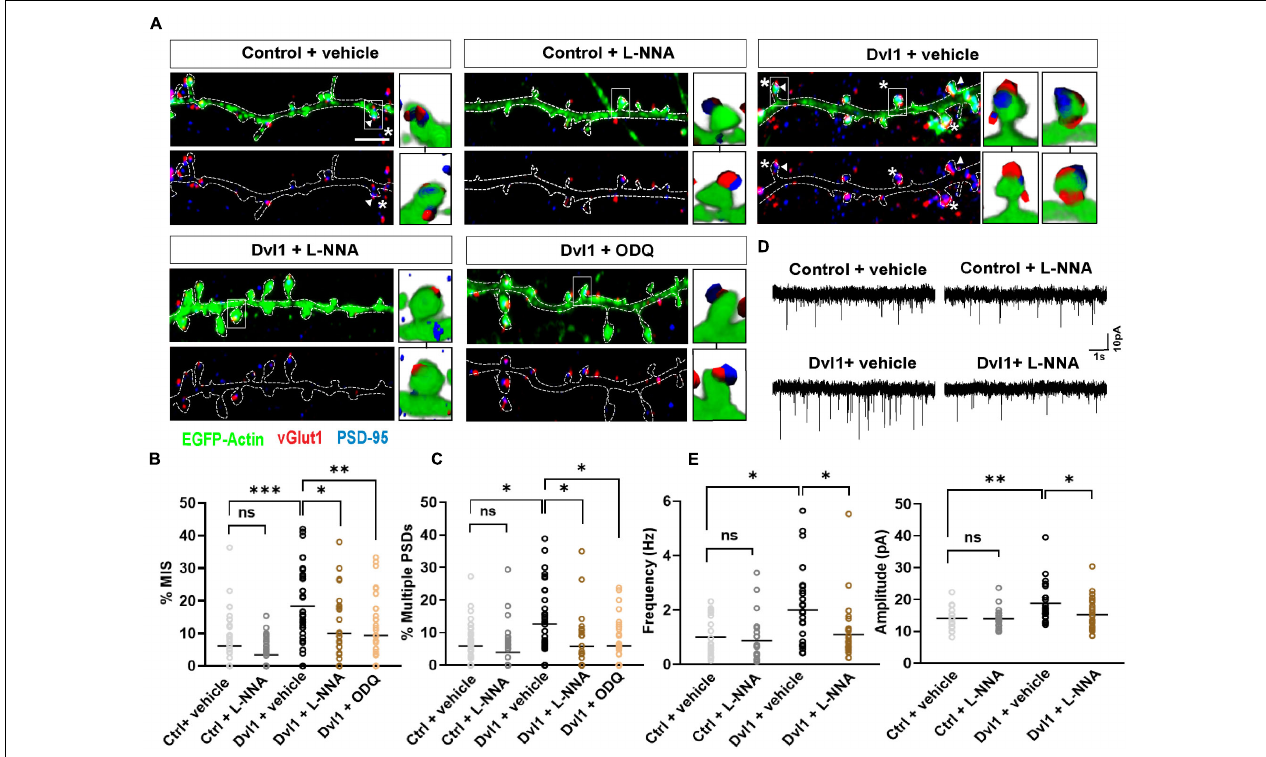
FIGURE 4 | Dvl1 promotes the formation of MIS through NO signaling. (A) Representative images of dendrites expressing EGFP-actin (green), or EGFP-actin and Dvl1 and immunostained for vGlut1 (red) and PSD-95 (blue). Following Dvl1 expression, neurons were treated with vehicle, the NOS inhibitor L-NNA or the sGC inhibitor ODQ. NO inhibition blocks the Dvl1 mediated formation of MIS (asterisks) and multiple PSDs (arrowhead). Scale bar = 5 µ m. Three-dimensional zoomed-in images display front (top) and back (bottom) representations of spines with one or more vGlut1 and PSD95 puncta. (B,C) Quantification of mean percentage of MIS (B) and spines (C) with multiple PSDs ( n = 37–42 cells from 3 independent cultures, * P < 0.05, ** P < 0.01, *** P < 0.001, n.s. = non-significant by Kruskal-Wallis test followed by Dunn’s post hoc test). (D) Representative 10 s traces of mEPSCs recorded from neurons, co-transfected with EGFP-actin and empty vector (control) or Dvl1-HA and treated with vehicle or the NOS inhibitor L-NNA. Dvl1 increases mEPSC frequency and amplitude, both of which are blocked by L-NNA. (E) Quantification of mean mEPSC frequency and amplitude [ n = 21–29 cells/condition from 3 independent cultures * P < 0.05, ** P < 0.01 by Kruskal-Wallis test followed by Dunn’s post hoc test in (frequency) and two-way ANOVA followed by Tukey post hoc test in